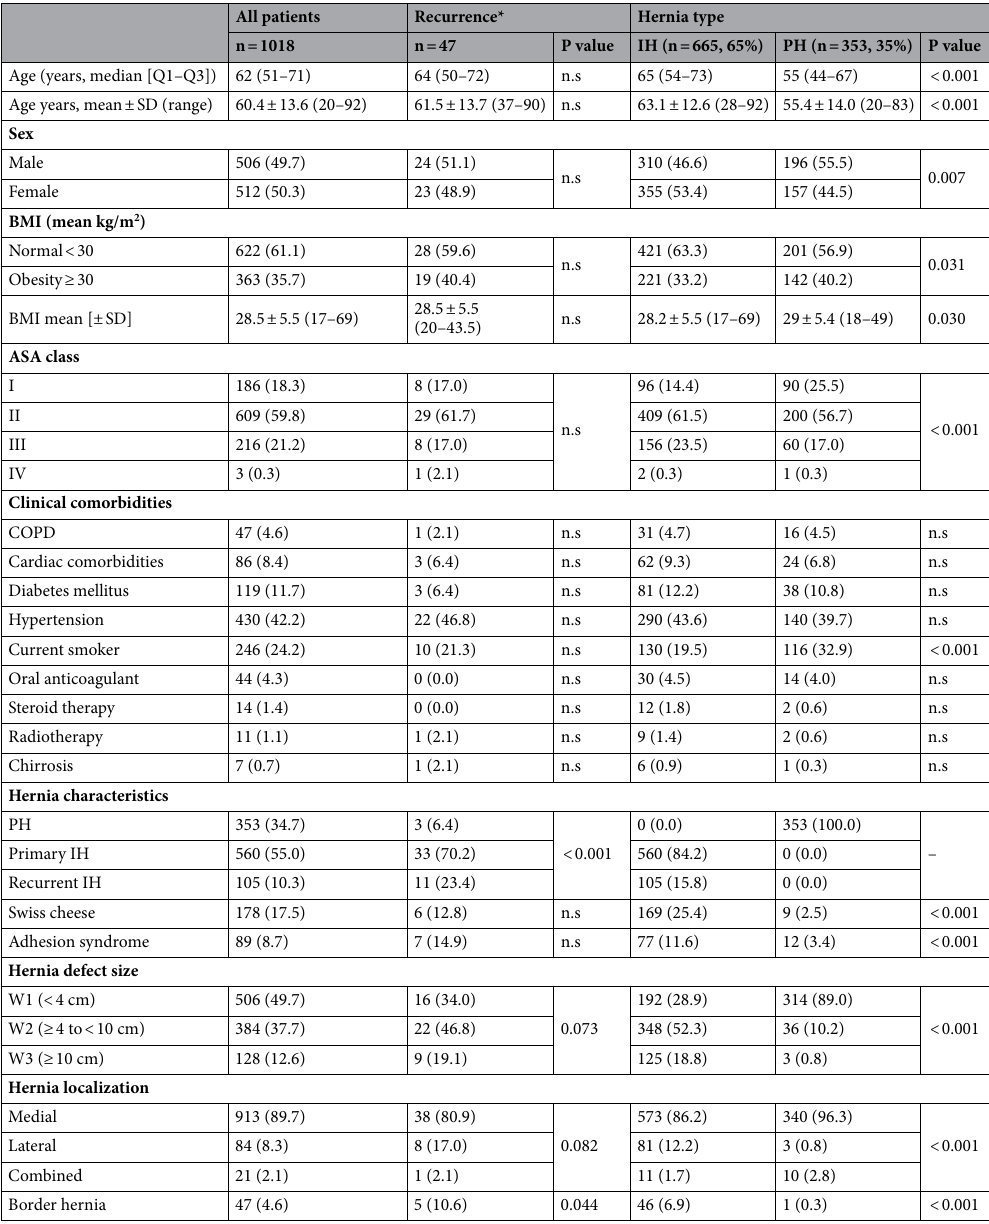
Table 1. Patient baseline demographic, clinical and hernia characteristics for all patients (n = 1018), recurrences* (n = 47) with significative risk factors (p value), and comparison between IH (n = 665) and PH (n = 353). *Comparison with all patients without recurrence (n = 971). Data presented were n (%), unless specified. Q1 ; first quartile, Q3 ; third quartiles; BMI , body mass index; ASA , American Society of Anesthesiologists; COPD , chronic obstructive pulmonary disease; n.s. , not